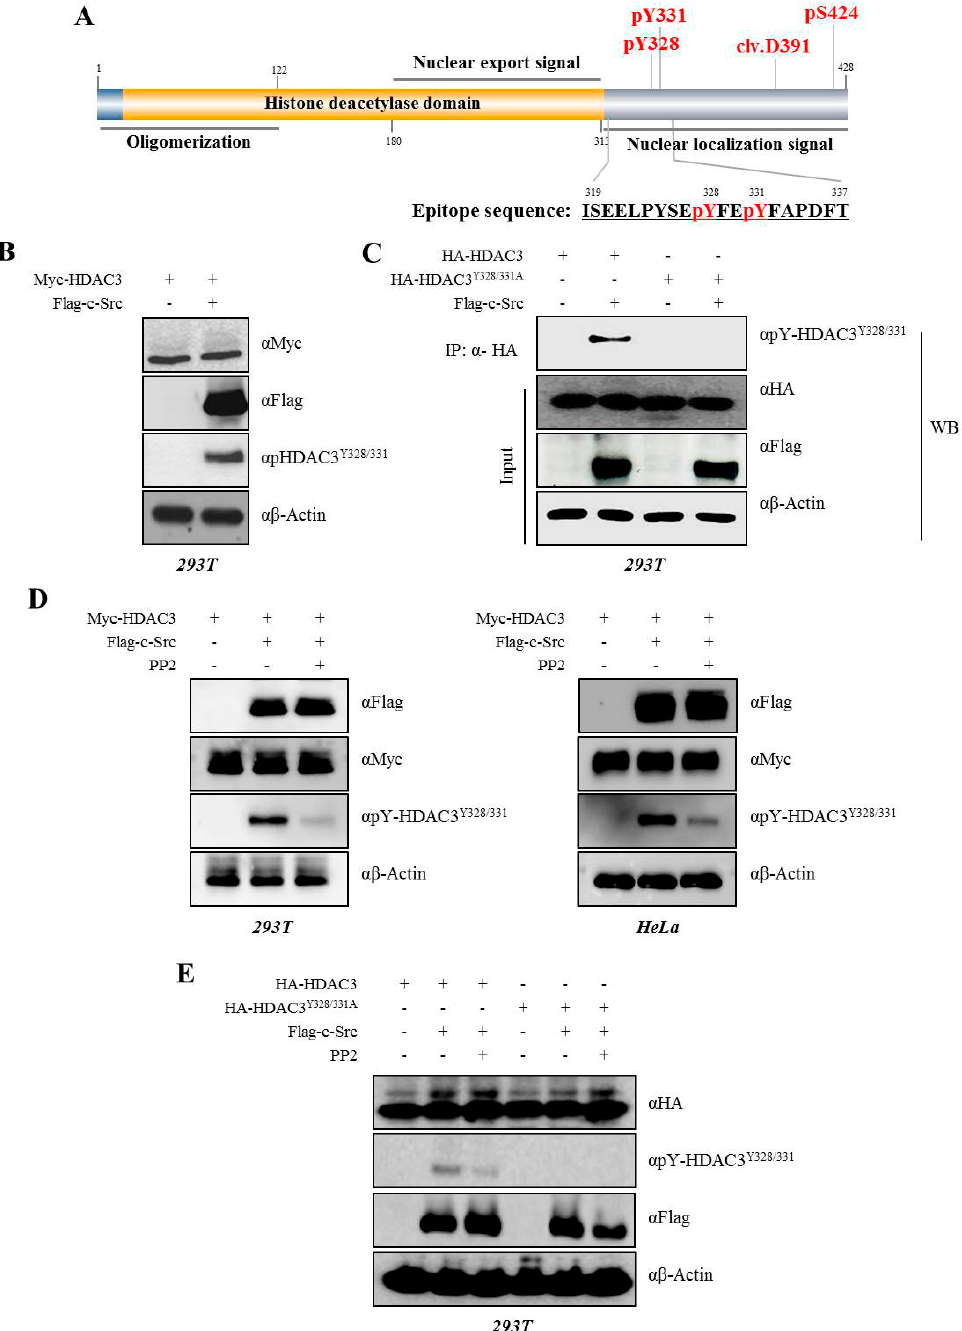
Figure 2. c-Src phosphorylates Y328 and Y331 on HDAC3 in 293T cells. ( A ) Modified peptide sequence for the generation of phospho-HDAC3 Y328/331 antibody. Schematic diagram of human HDAC3 protein with multiple functional domains. Residues 1 to 122 are necessary for HDAC3 oligomerization. The actual functional nuclear export signal and nuclear localization signal reside